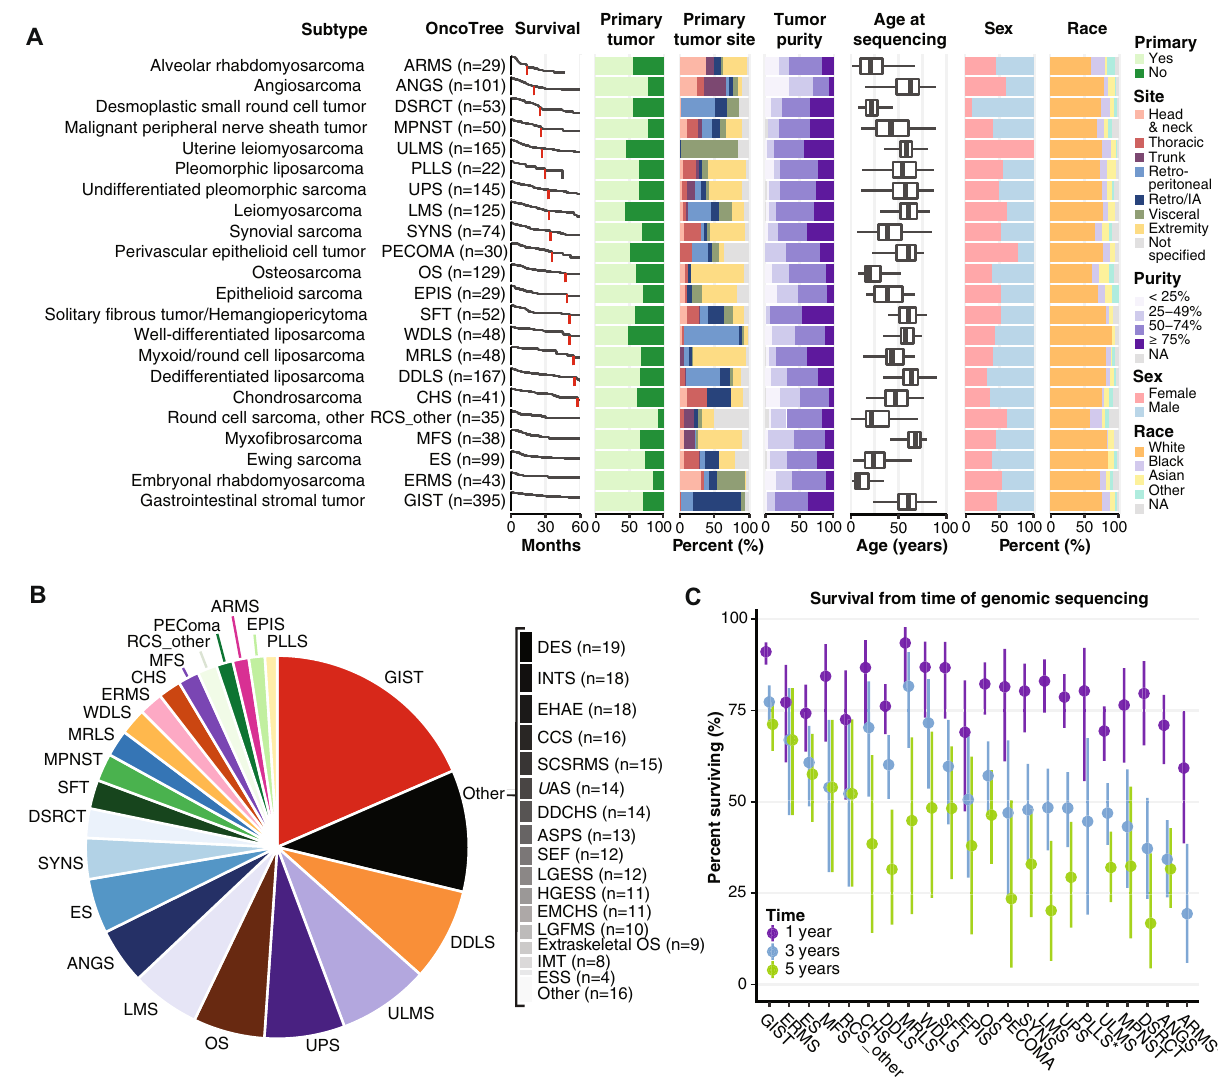
Fig. 1 Analysis of 2138 sarcoma samples reveals variation in patient characteristics among subtypes. This analysis includes 2138 bone and soft tissue sarcoma samples, each from distinct patients. Subtypes with ≥ 20 samples in the dataset are displayed. A Distribution of number of samples, survival from time of sequencing, sample type (primary or metastatic site), tumor site, sample purity, age, sex, and self-reported race in each subtype. Retro/IA, retroperitoneal or intrabdominal. NA, not applicable. In the age plot, box boundaries indicate 25th and 75th percentiles, interior lines medians, and whiskers 1.5 times the interquartile range. B Overall distribution of sample number for the entire cohort. C 1, 3, and 5-year survival from the time of sequencing. *, 5-year survival = 0. Vertical lines indicate 95% con fi dence intervals. DES desmoid tumor, ESS endometrial stromal sarcoma, INT intimal sarcoma, LGFMS low-grade fi bromyxoid sarcoma, EMCHS extraskeletal myxoid chondrosarcoma, HGESS high-grade endometrial stromal sarcoma, LGESS low-grade endometrial stromal sarcoma, SEF sclerosing epithelioid fi brosarcoma, ASPS alveolar soft part sarcoma, DDCHS dedifferentiated chondrosarcoma, UAS uterine adenosarcoma, SCSRMS spindle cell/sclerosing rhabdomyosarcoma, CCS clear cell sarcoma, EHAE epithelioid